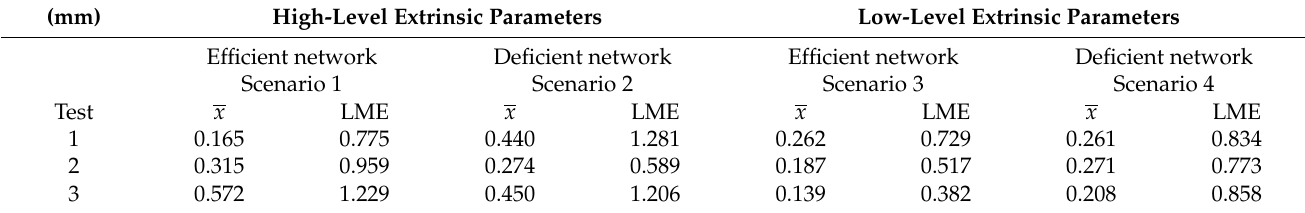
Table 4. Results of the trials for the efficient and deficient networks using low-level and high-level extrinsic